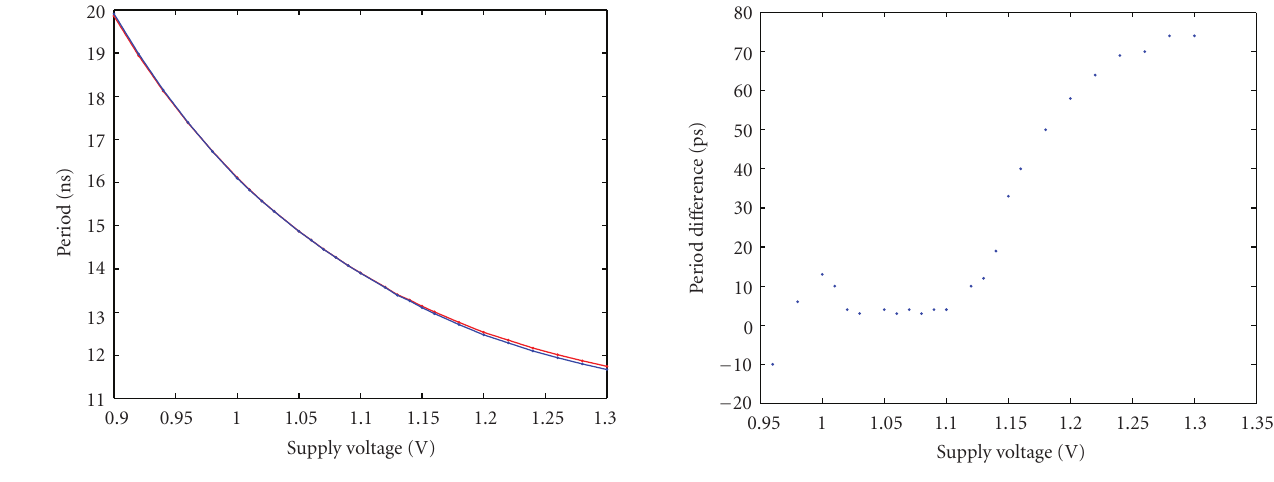
Figure 12: Di ff erence between clock periods of two rings depending on the power